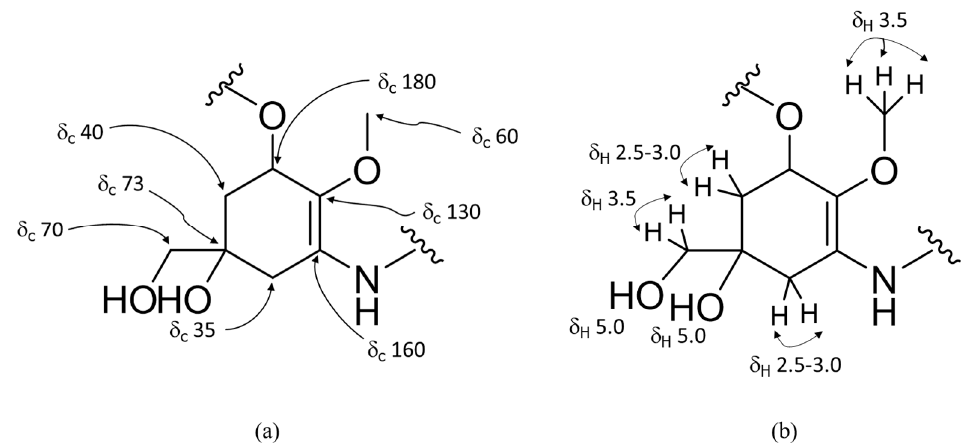
Figure 3. Structure of an oxomycosporine with NMR results for ( a ) 13 C (125 MHz, D 2 O) and ( b ) 1 H (500 MHz, D 2 O). For iminomycosporine 13 C NMR (125 MHz, D 2 O) δ C = 160 (C-1).